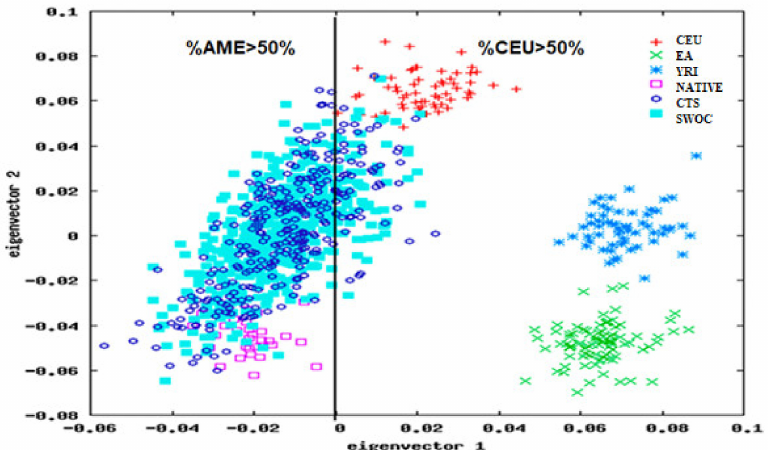
Figure 1. Principal component analysis in CTS and SWOC groups. Reference populations: Caucasian (CEU), East Asian (EA), and African (YRI) populations from the international HapMap project and Amerindian population of Mexican Genome Diversity Project (NATIVE). AME: high Amerindian component. CEU: high Caucasian component.